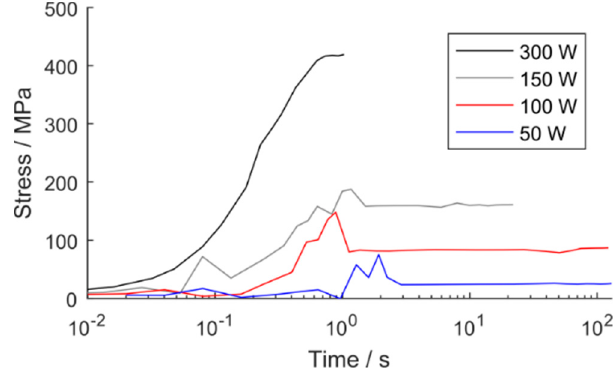
Figure 4. Maximum thermal induced stress (principal stress) as a function of laser power and irradiation time.